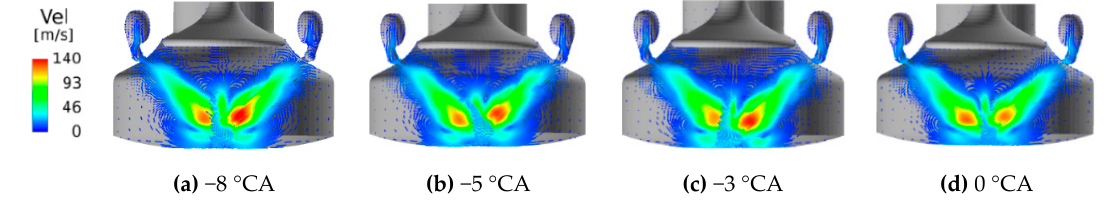
Figure 13. Flame velocity vector distribution at 2 °CA after pilot injection.